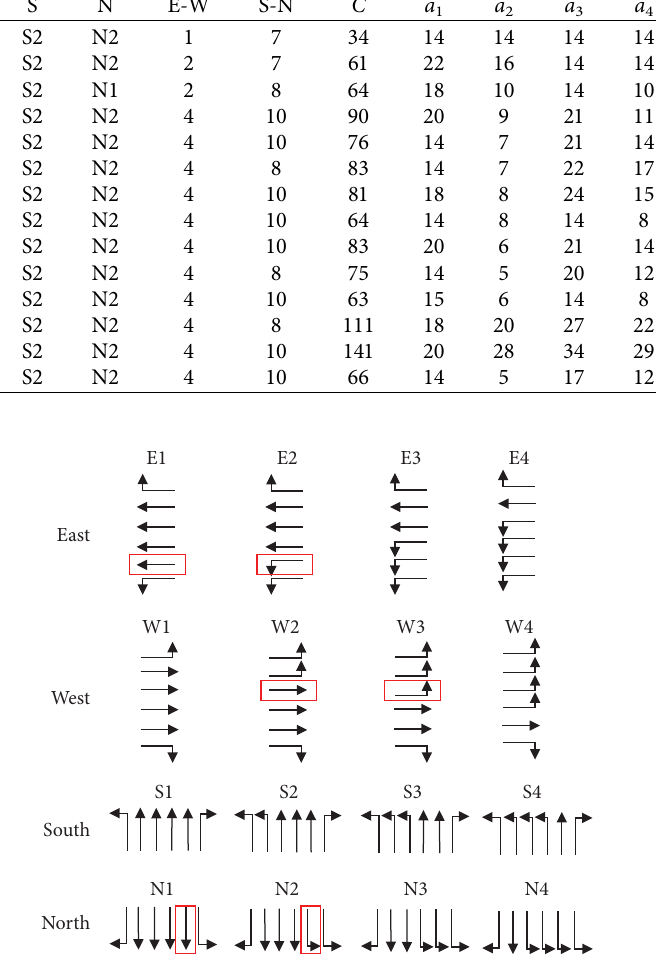
Figure 10: Optional lane-use assignment schemes in the east, west, south, and north entrances.